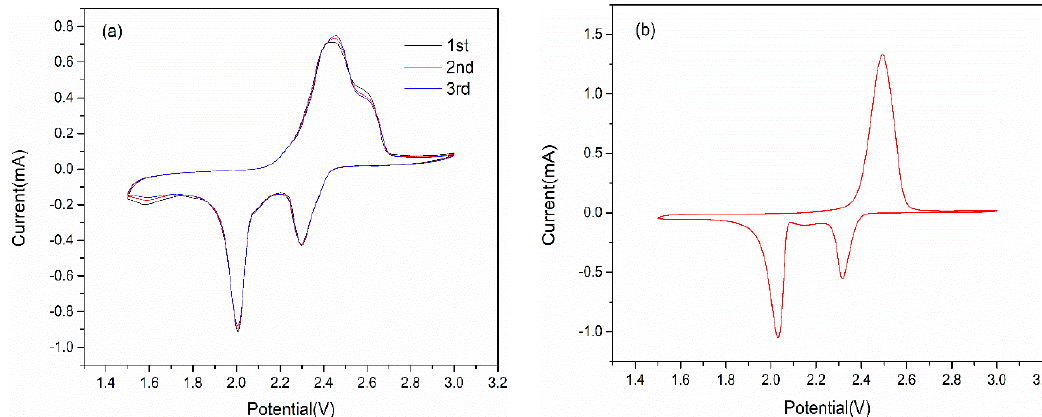
Figure 1. The first three cycles of the battery with the Thiokol binder and first cycle of the battery with the polyvinylidene fluoride (PVDF) binder at a sweep rate of 0.1